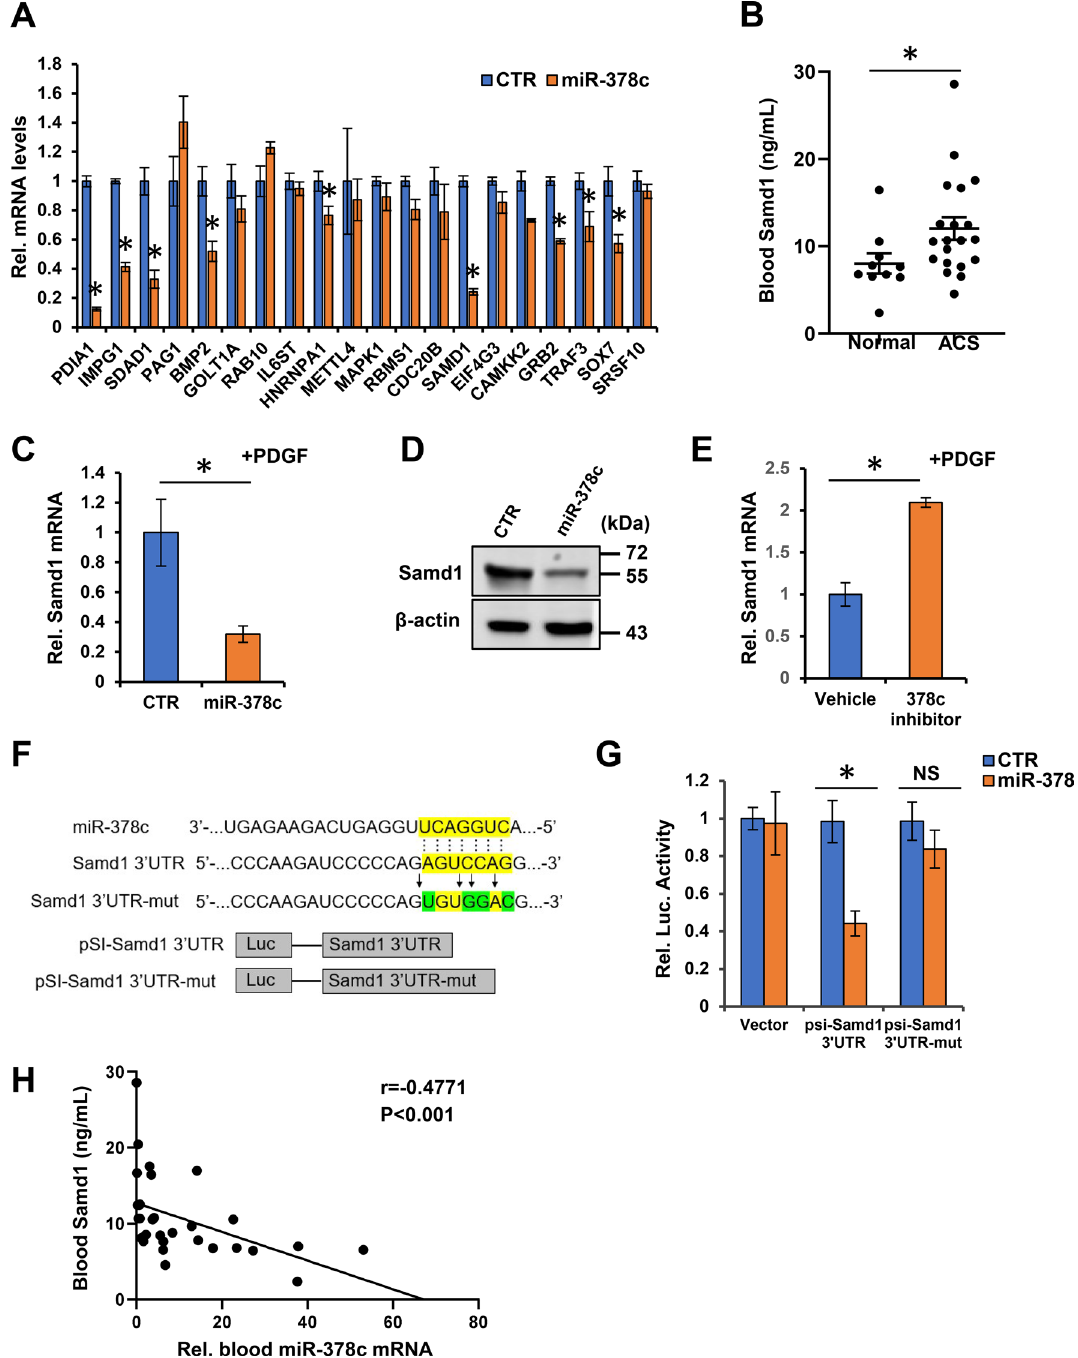
Figure 3. Identification of miR-378 targets in VSMCs. ( A ) Genes contain evolutionary conserved predicted binding sites of human miR-378c and involved in atherosclerosis were assessed by the regulation of miR-378c in VSMCs stimulated with PDGF-BB using qRT-PCR. Data were presented as mean ± SD, n = 4. *P < 0.05 as compared with PDGF-treated mimic control group. ( B ) Blood Samd1 protein levels were measured in 20 ACS patients and 10 healthy subjects. Data were presented as mean ± SD. *P < 0.001 as compared between two groups. ( C , D ) VSMCs stimulated with PDGF-BB were further transfected with miR-378c mimic. Samd1 mRNA and protein levels were measured by qRT-PCR ( C ) and western blotting ( D ), respectively. Data were presented as mean ± SD, n = 4. *P < 0.05 as compared with PDGF-treated mimic control group. β-actin serves as a loading control. ( E ) VSMCs stimulated with PDGF-BB were further transfected with miR-378c inhibitor. Samd1 mRNA level was measured by qRT-PCR. Data were presented as mean ± SD, n = 4. *P < 0.05 as compared with PDGF-treated vehicle group. ( F ) Predicted base pairing between miR-378c and 3 ′ UTR of Samd1 by RNA hybrid software. Wild-type or mutated (mut) 3 ′ UTR of Samd1 sequence inserted into dual-luciferase vector were shown. ( G ) miR-378c mimics were co-transfected with pSI-Samd1-3 ′ UTR or pSI-Samd1-3’UTR-mut into HEK293 cells followed by dual-luciferase analysis. *P < 0.05 compared between the indicated groups, n = 4. ( H ) Correlation between blood miR- 378c level and blood Samd1 protein level. n = 30. Statistical significance was determined by the chi-square